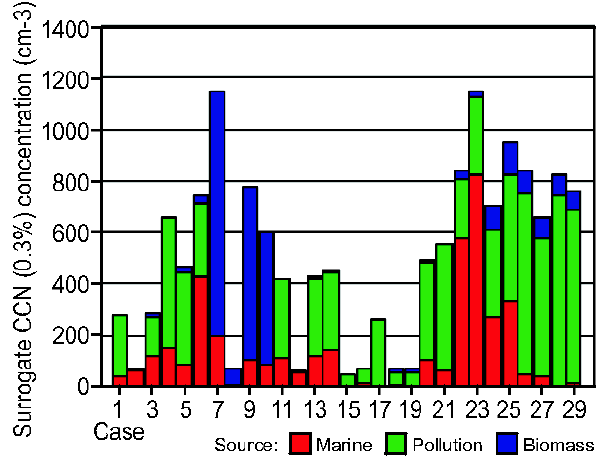
Figure 6. Source contributions to the surrogate CCN (0.3%) concentration of each of the three sources to each sample taken during the CARMA III study. The samples shown were taken consecutively between August 6 th and 26 th , 2005.